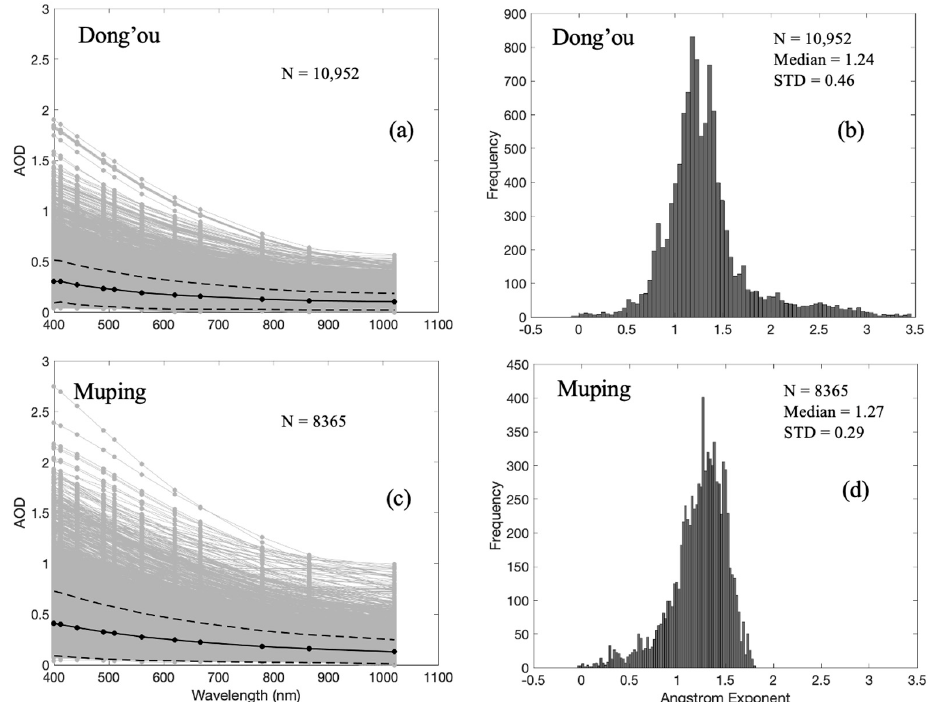
Figure 8. SeaPRISM − measured spectral aerosol optical depth (AOD) at the ( a ) Dong’ou and ( c ) Mup- ing sites. The grey lines represent all AOD measurements. The black solid and dash lines are the median and one standard deviation of AOD. ( b , d ) are the histograms of Ångström Exponent at Dong’ou and Muping sites, respectively.